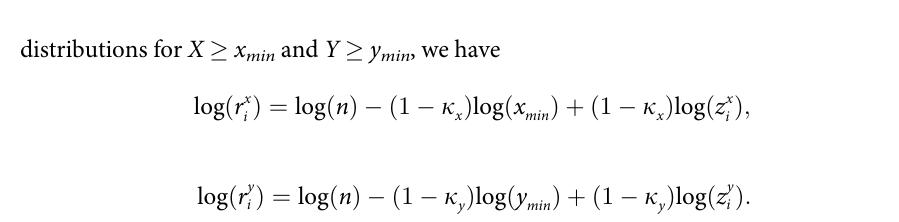
Fig 2. Normalizing profiles 47 and 107. Profile 47 has the smallest mean expression (solid curve) and profile 107 has the largest mean expression (dashed curve). The dash-dotted curve shows the Zipf plot of profile 107 after normalization (with both rescaling and power transformation). The solid and dashed straight lines are the fitted least squares lines of log( Rank ) against log( X ) based on genes with log( Rank ) < 6) for profiles 47 and 107, respectively. The dash-dotted straight line shows the fitted least squares line for profile 107 after rescaling but before power transformation.